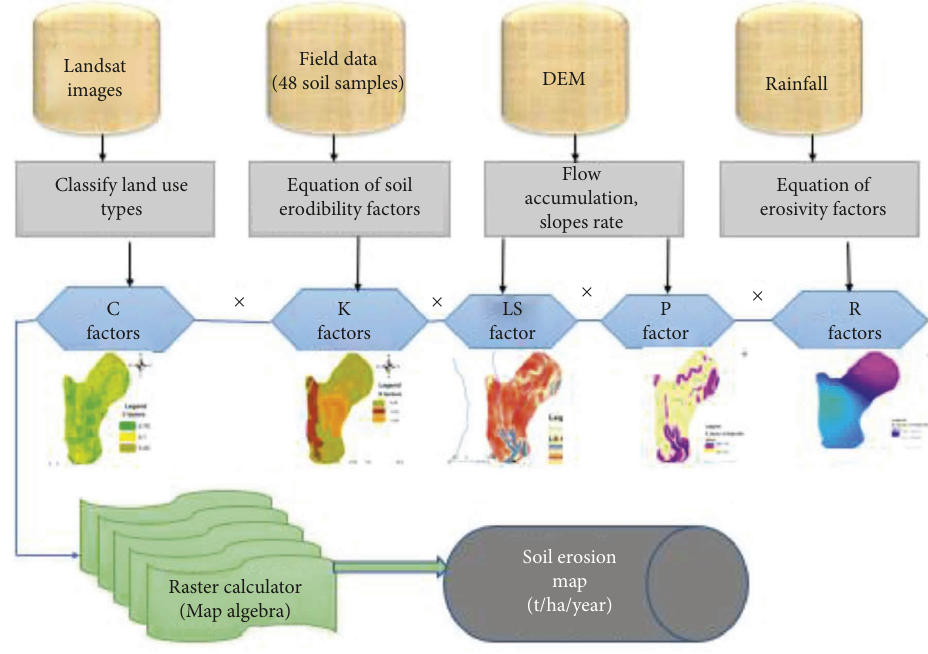
Figure 2: Modelling soil erosion.